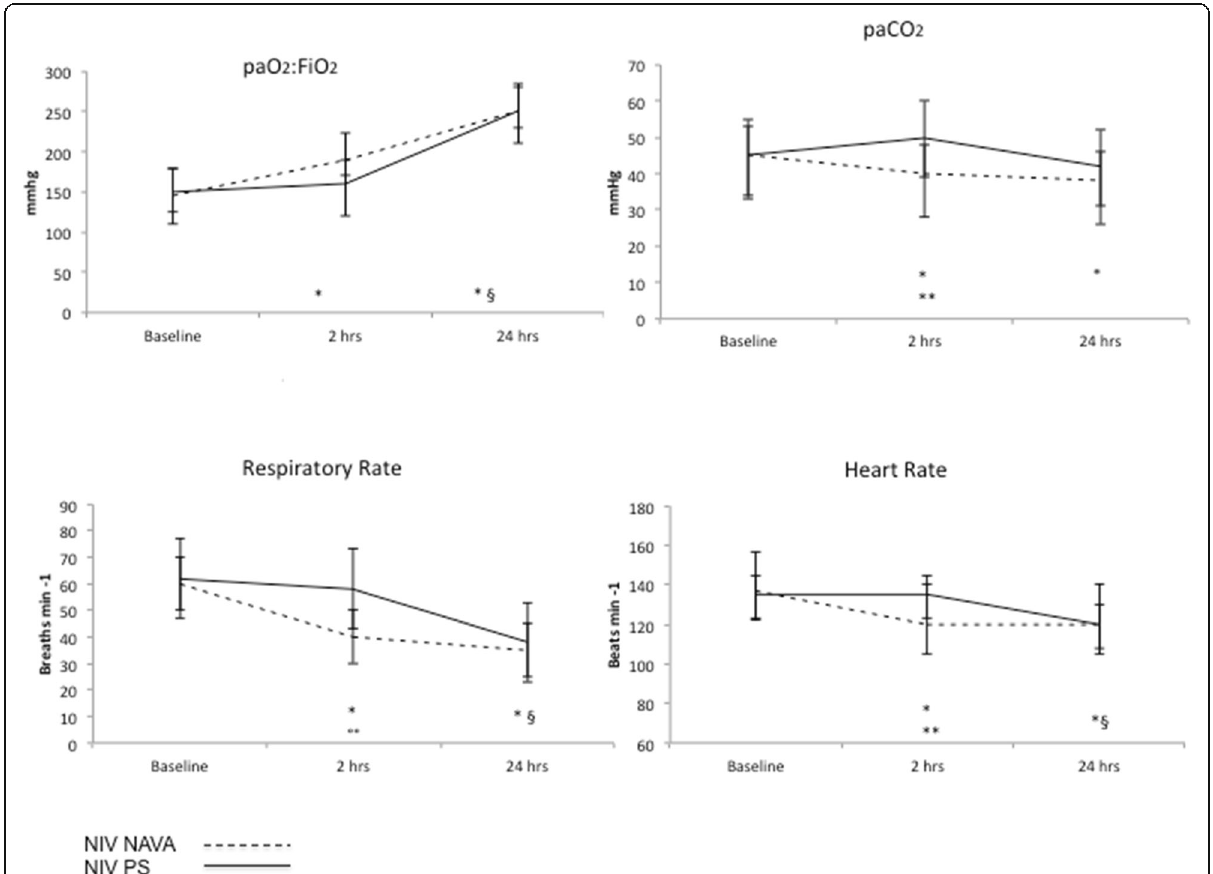
Fig. 2 Physiologic parameters. NIV-PS, noninvasive pressure support; NIV-NAVA, noninvasive neurally adjusted ventilatory assist; paO 2 :FiO 2 , arterial oxygen tension to inspired oxygen fraction ratio; paCO 2 , arterial carbon dioxide partial pressure; RR, respiratory rate; HR, heart rate. Data are collected at baseline at PICU admission, 2 h after starting NRS in each group ( n 30 patients in NIV-NAVA and 34 patients in NIV-PS group), and at 24 h in nonintubated patients in both groups ( n 26 patients in NIV NAVA and n 14 patients in NIV-PS group). * p < 0.05: NIV NAVA comparison at 2 and 24 h vs baseline; § p < 0.05: NIV-PS comparison at 24 h vs baseline; °° p < 0.05: NIV NAVA vs NIV PS at 2 h; ** p < 0.001: NIV NAVA vs